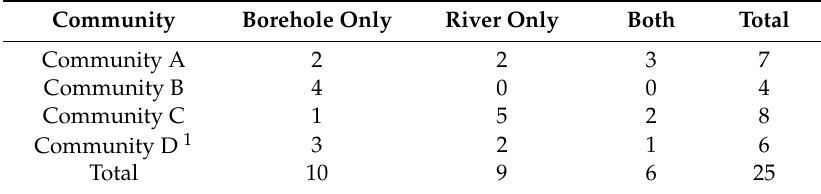
Table 1. Number of participants who use boreholes and river water in each community 1,2,3,4 . Community Borehole Only River